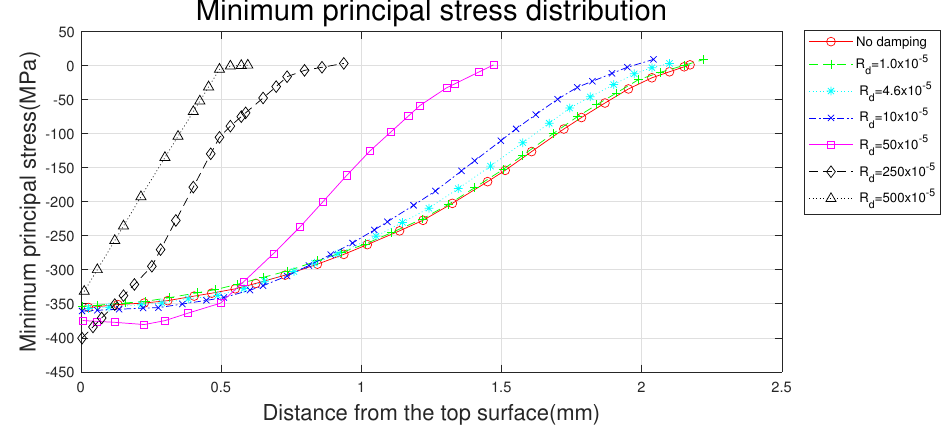
Figure 17. Minimum principal stress of multiple LSP FE solution in the depth (z-) direction at face No. 16 in Figure